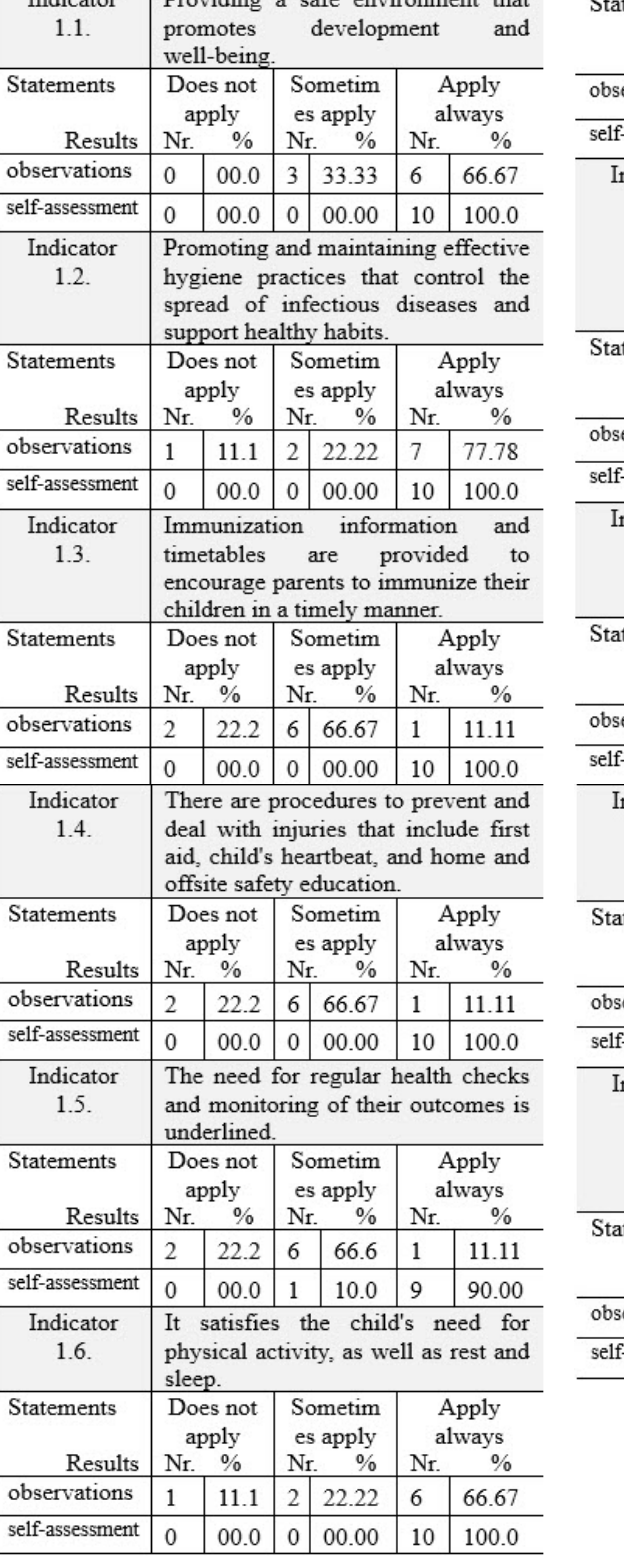
Table 14. Principle 1: Every child’s health is encouraged.